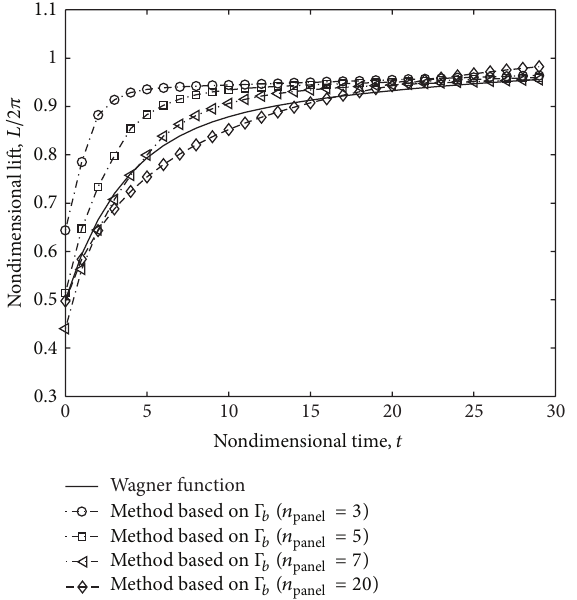
Figure 6: Unsteady lift for two-dimensional airfoil predicted using ROM based on Γ 𝑏 .